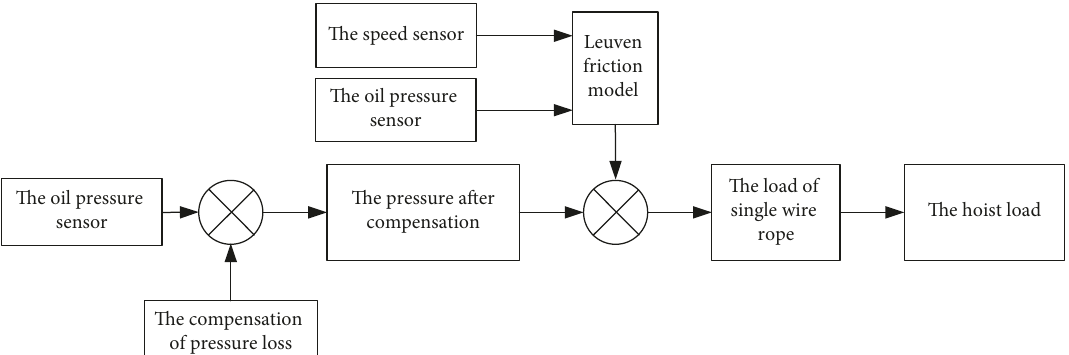
Figure 21: Compensation scheme for wire rope tension and load.